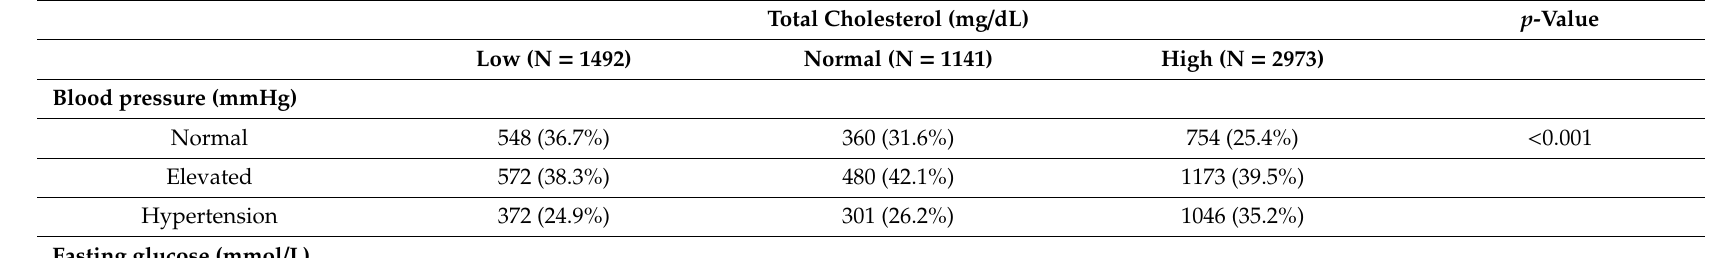
Table A7. Distribution of total cholesterol groups according to blood pressure, fasting glucose, and glomerular filtration rate